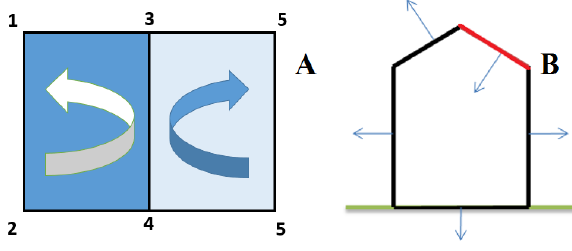
Figure 11. Healing CS_FACEORIENT error